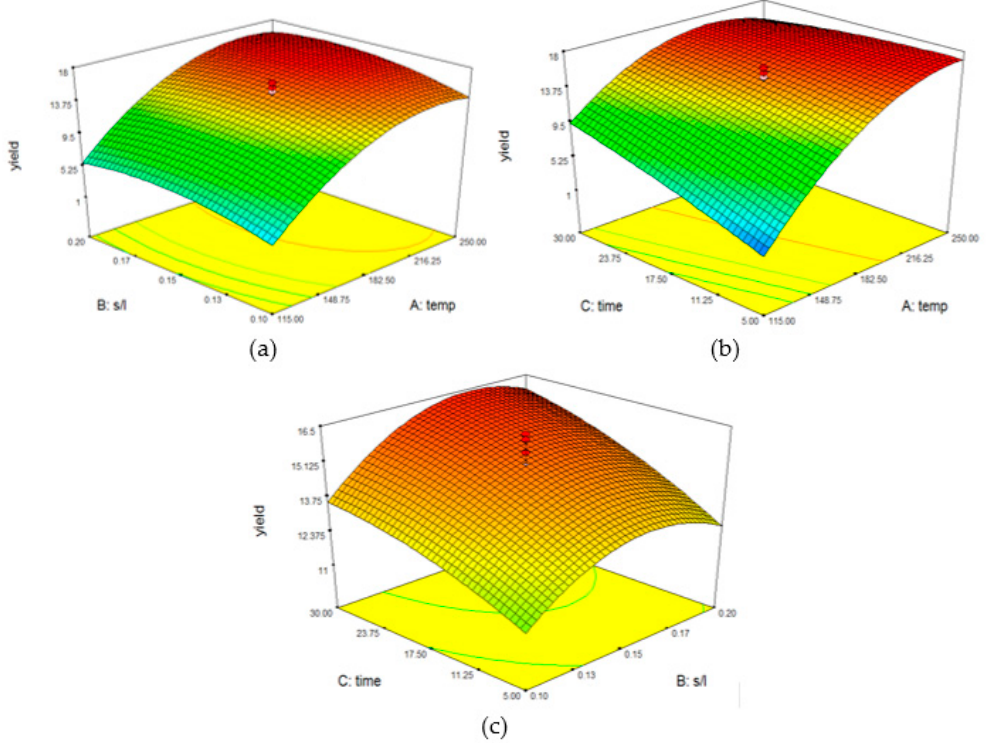
Figure 3. 3D response surfaces for investigations on the interactive effect of variables with ( a ) denoting the temperature versus sample-to-solvent ratio, ( b ) denoting the time versus temperature ratio, and ( c ) denoting the time versus sample-to-solvent ratio, with regards to the extraction of essential oil from A . malaccensis wood.